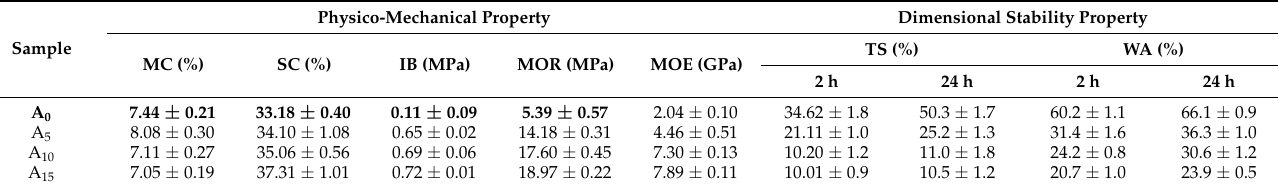
Table 1. PMDSP of particleboard phantoms.